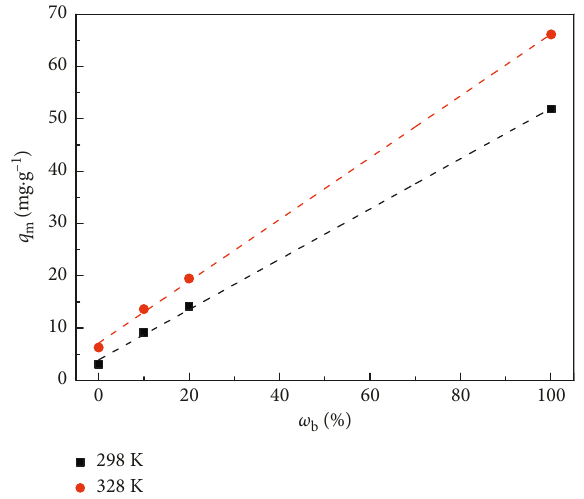
Figure 10: Comparison between the predicted values and exper- imental results of maximum Pb(II) adsorption by laterite-bentonite